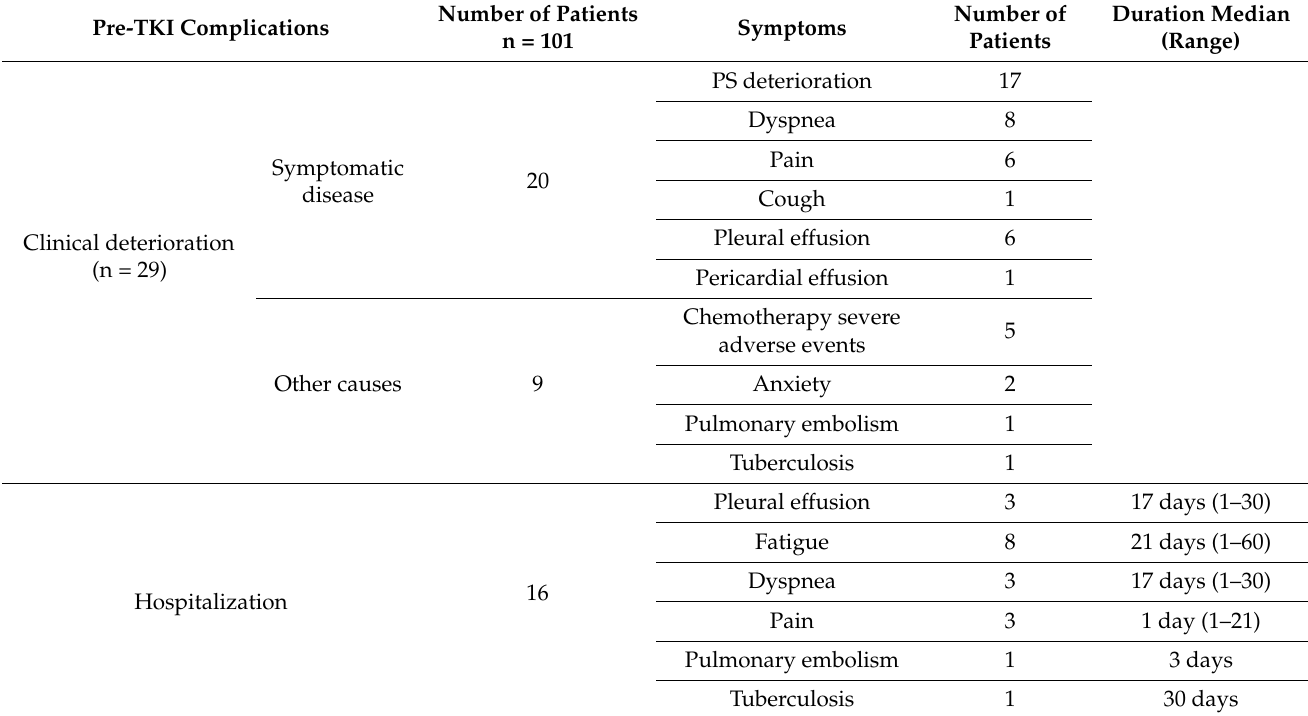
Table 4. Complications reported during the pre-TKI period. N = 101, 1 patient with non-available data. PS = performance status. Pre-TKI